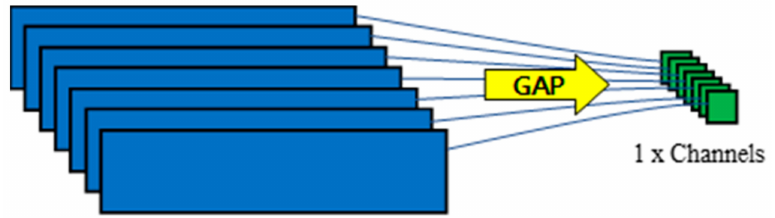
Figure 3. Global average pooling (GAP)